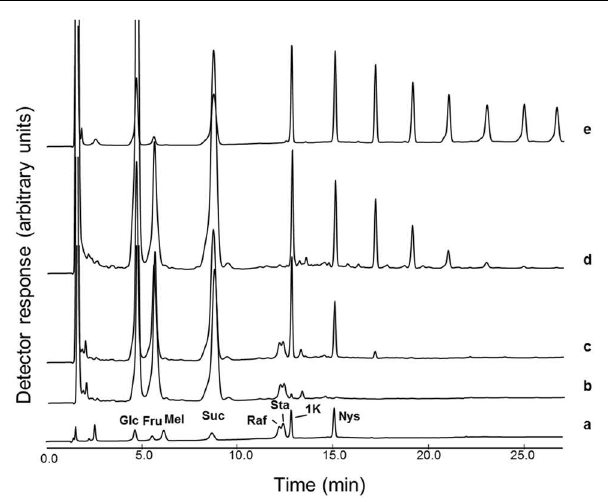
FIGURE 1 | Buxus leaves can contain both FOS and RFO. HPAEC-IPAD chromatograms showing (a) a reference sample (Glc: glucose; Fru: fructose; Mel: melibiose; Suc: sucrose; Raf: raffinose; Sta: stachyose; 1K, 1-kestotriose; Nys: 1,1-nystose); (b) Belgian Buxus leaf soluble carbohydrates (see c ) treated with the heterologous chicory root 1-FEH IIa enzyme (0.1 nkat, 30 ◦ C, 2h); (c) Belgian Buxus leaf soluble carbohydrates (sampled March 26, 60 µ g material); (d) Mediterranean Buxus leaf soluble carbohydrates (July 15, 60 µ g material); (e) mature chicory root soluble carbohydrates (August 29, 60 µ g